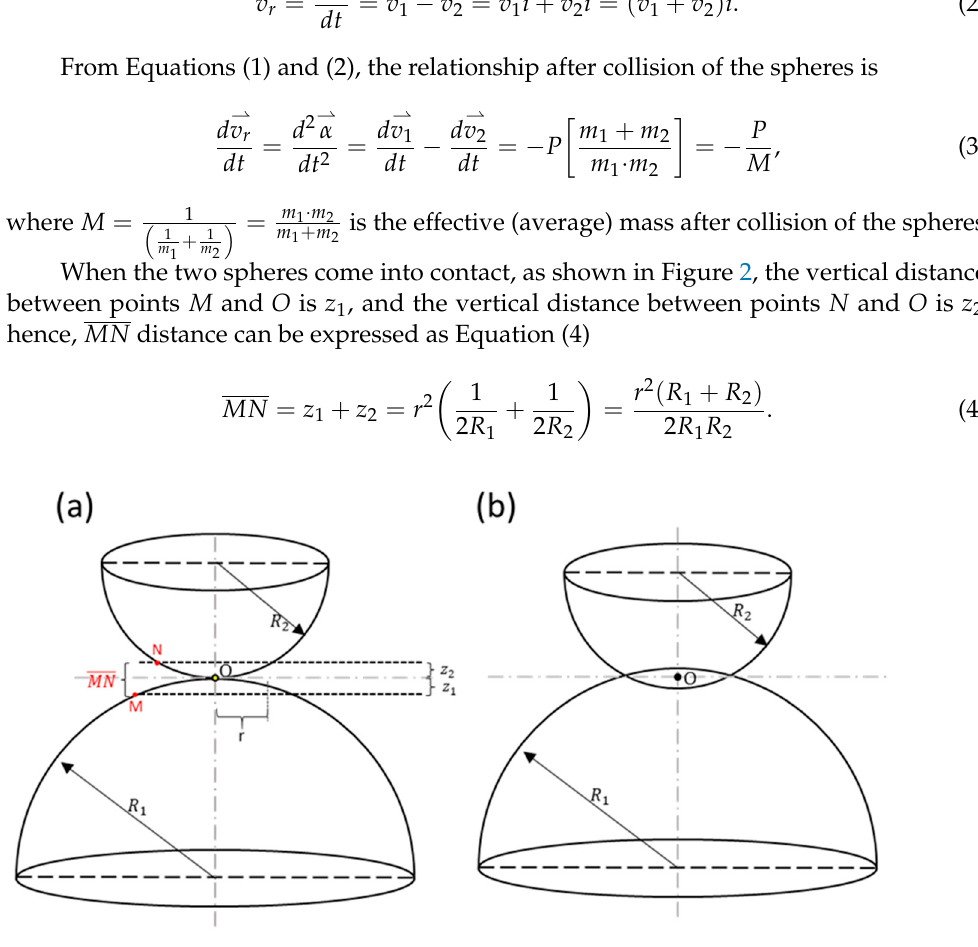
Figure 2. Schematic of compression changes after collision of two balls ( a ) coming into contact with each other and ( b ) colliding with each other.